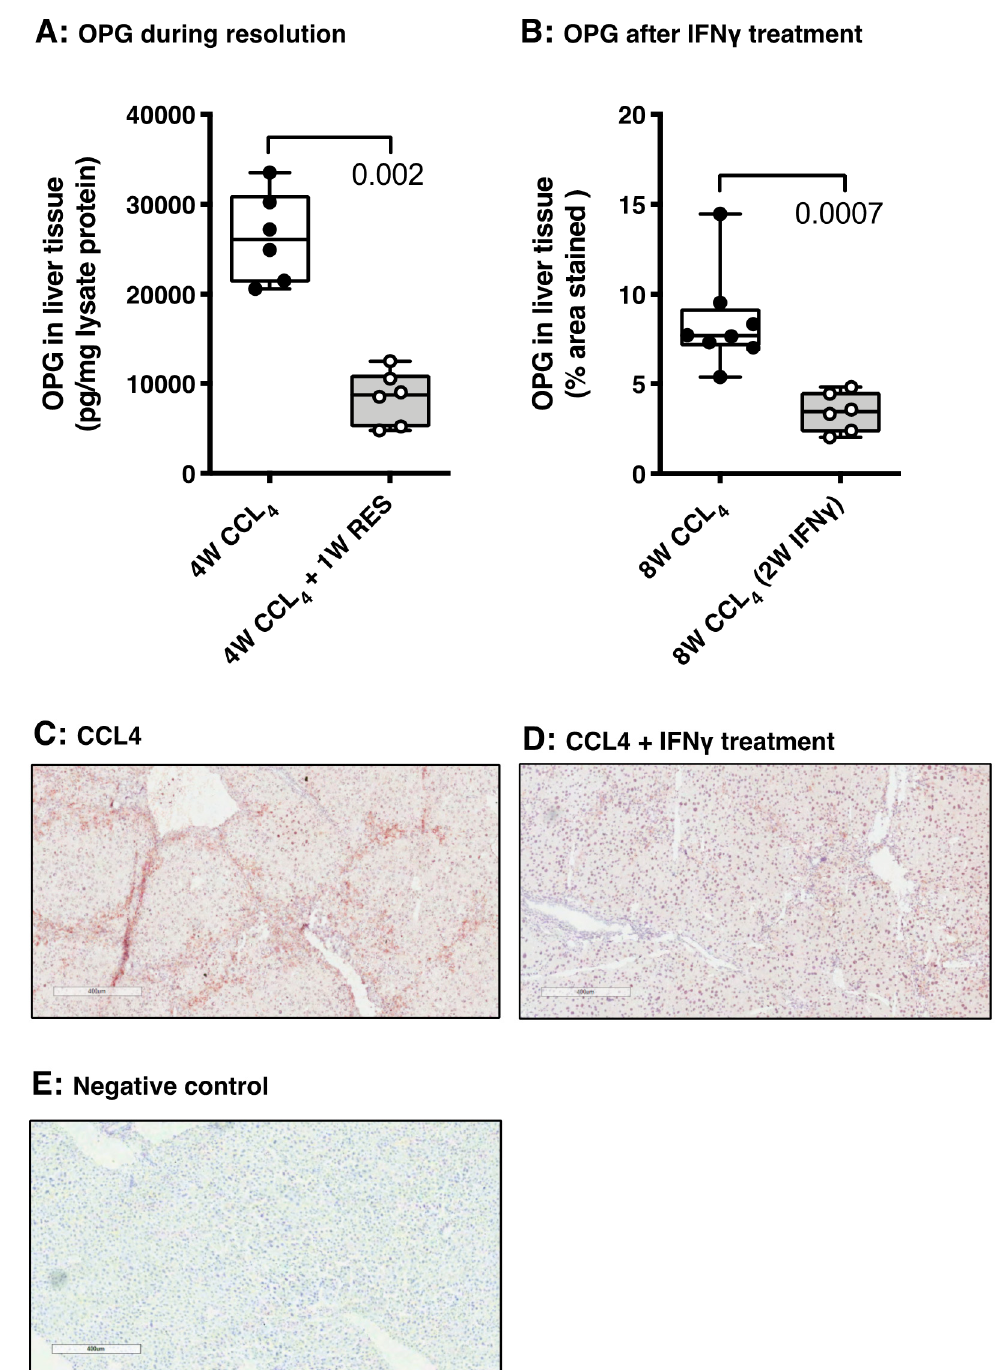
Figure 8. OPG responds to spontaneous and drug (IFN γ )-induced resolution. In vivo spontaneous ( A ) and interferon gamma (IFN γ )-induced ( B ) resolution of CCl 4 -induced liver fibrosis in mice resulted in lower OPG levels in liver tissue as compared to their respective controls, which was accompanied by lower collagen type I deposition as was published by us before [28,29]. ( C ) Example of the OPG staining in liver tissue of mice with CCl 4 -induced liver fibrosis that was quantified in panel B (magnification 100 × ). ( D ) Example of the OPG staining in liver tissue of mice with CCl 4 -induced liver fibrosis treated with IFN γ for 2 weeks that was quantified in panel B (magnification 100 × ). ( E ) Negative control for the OPG staining (100 × magnification). Groups were compared using Mann–Whitney U, p < 0.05 was considered significant.